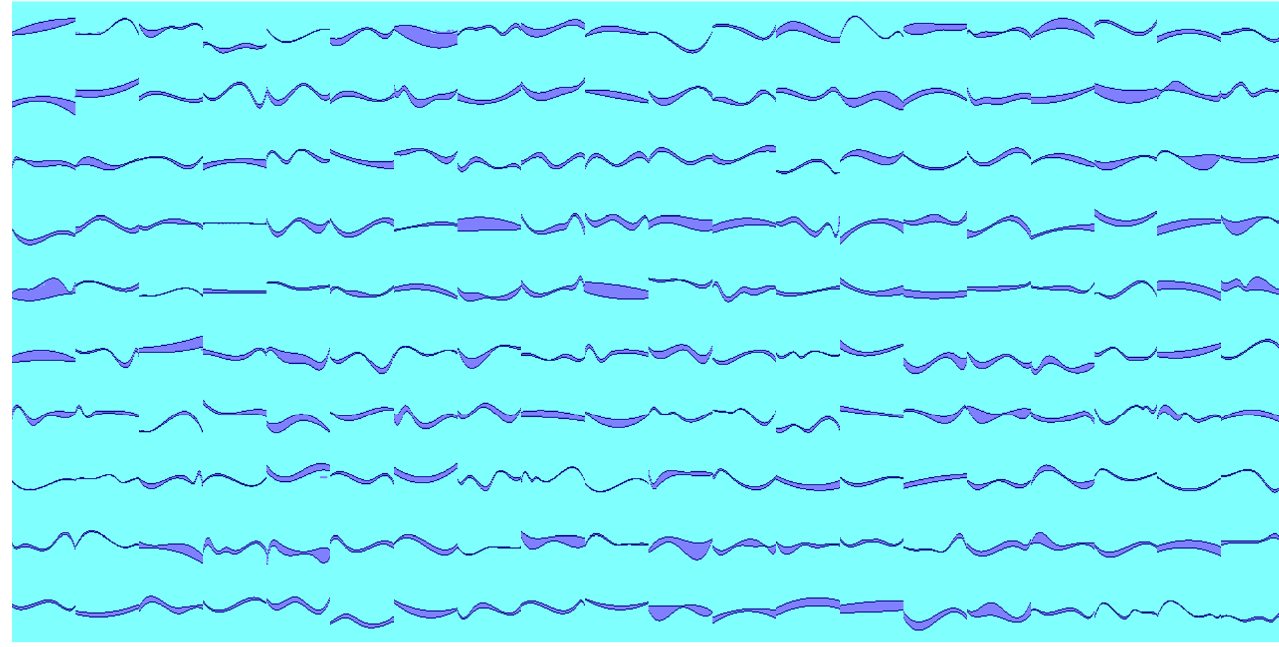
Fig. 10. The stack of 200 almost perfectly segmented test images and the fused overlay image as visualization of the performance of the SSN trained for 150 epochs by Fig. 5 without DropOut. Along with the test instance in Fig. 9, a few lacks can be seen (e. g., see the 7-th image with the thick stripe in the upper row).